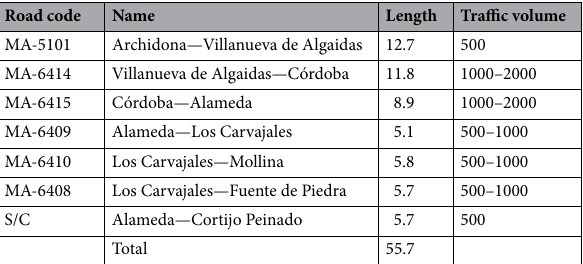
Table 1. Features of the roads sampled in the study area. Road length is given in kilometers. Traffic volume represents the average number of vehicles/day estimated on the road 34,41 .